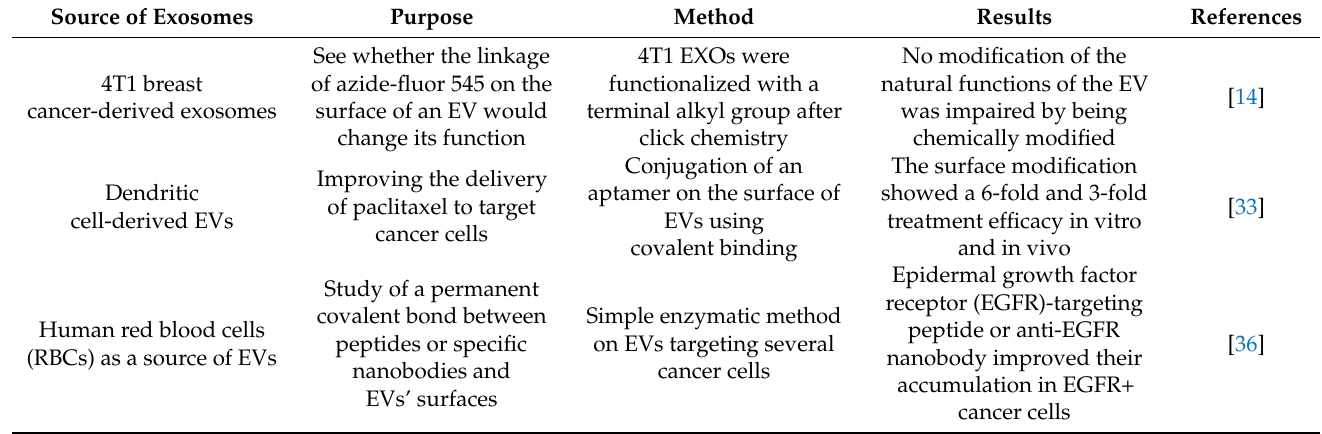
Table 3. Summary of the studies dealing with chemical modifications of extracellular vesicle-mediated delivery cargo using covalent binding